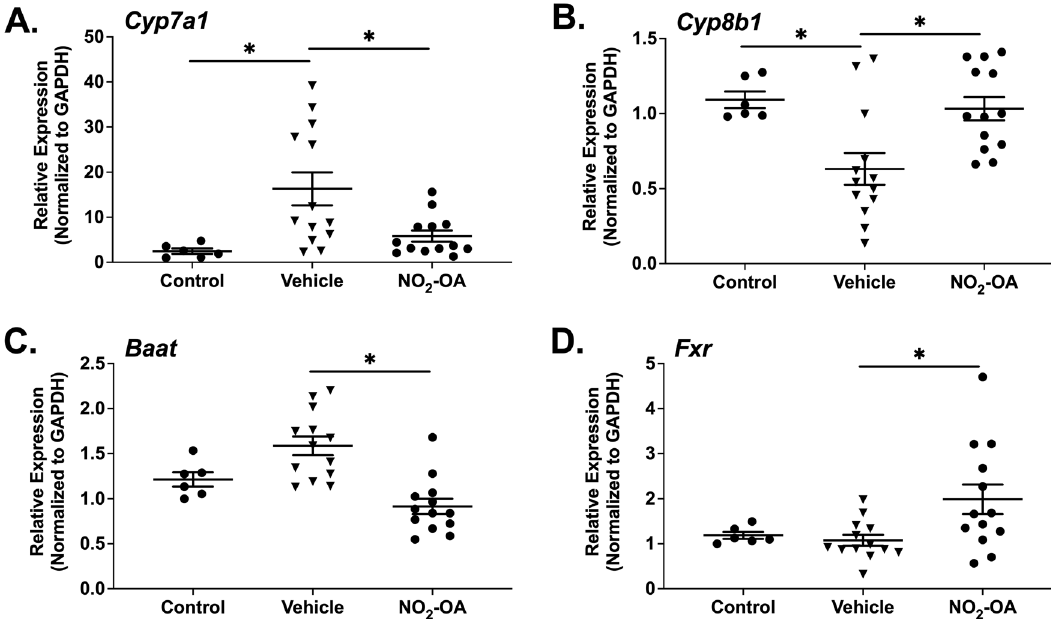
Figure 6. NO 2 -OA treatment abrogates the effects of allergic airway disease on bile acid synthesis. Bile acid synthesis in the liver was evaluated in obese mice with and without AAD following vehicle or NO 2 -OA treatment using real time PCR. Cyp7a1 (A) , Cyp8b1 (B) , bile acid-CoA N -amino acyltransferase ( Baat, C ), and Fxr (D) mRNA expression were normalized to Gapdh and expression shown is relative to obese control